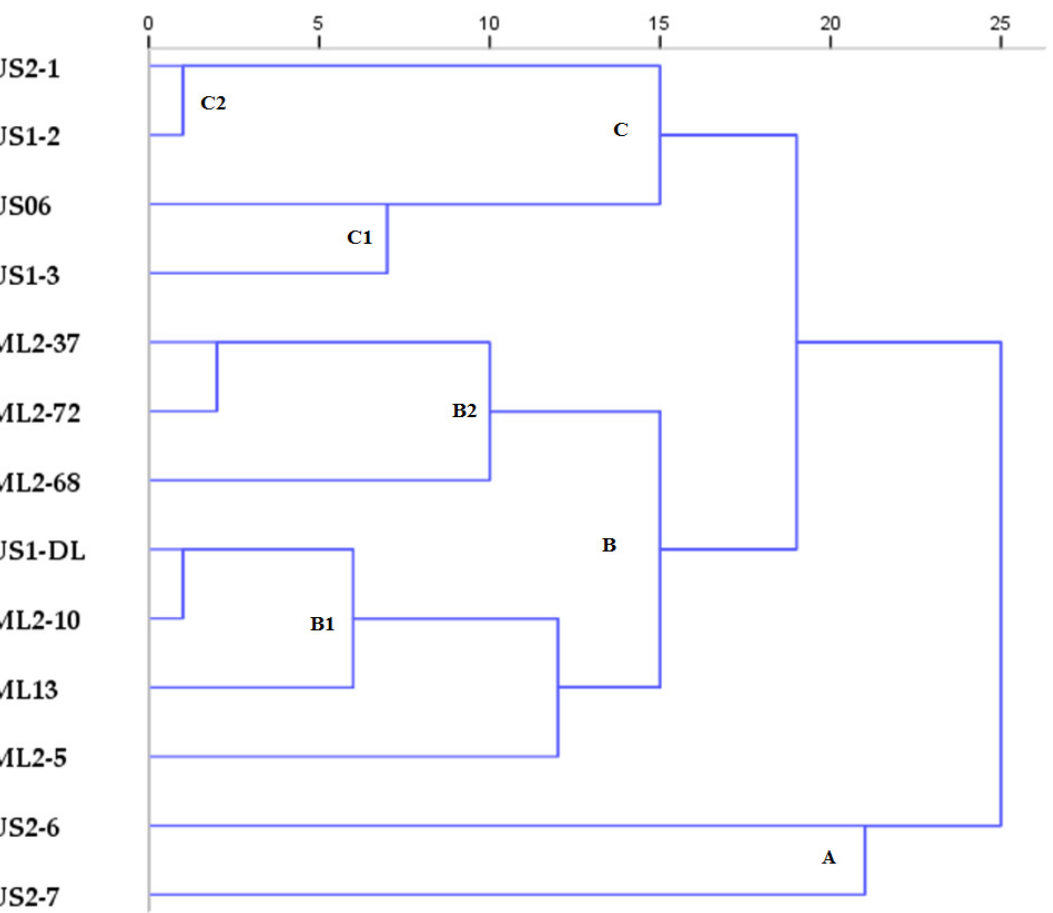
Figure 11. UPGMA-based dendrogram depicting genetic relationships among 13 sesame genotypes based on Euclidean dissimilarity estimates for ten agromorphological